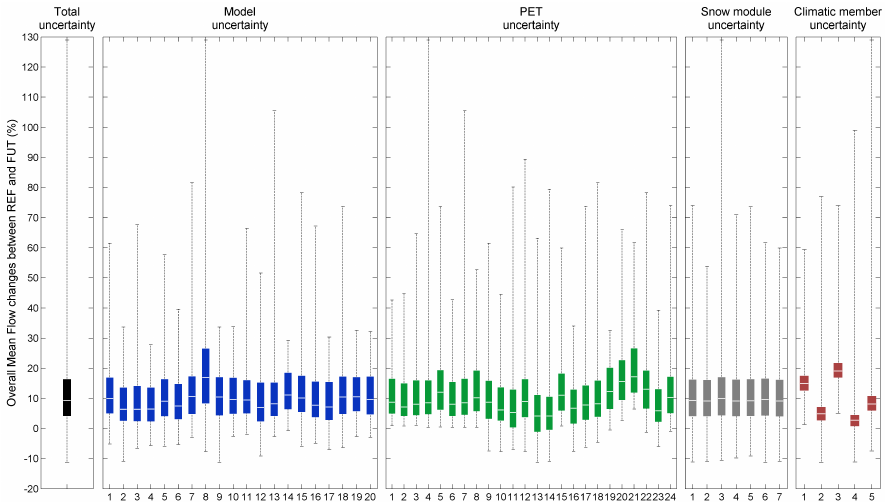
Figure 9. Total (black box plot), process-based, and climate overall mean flow evolution (from REF to FUT, %) uncertainty. Blue box plots correspond to the lumped conceptual hydrological models, green box plots to the PET formulations, grey box plots to the snow modules and red box plots to the climatic